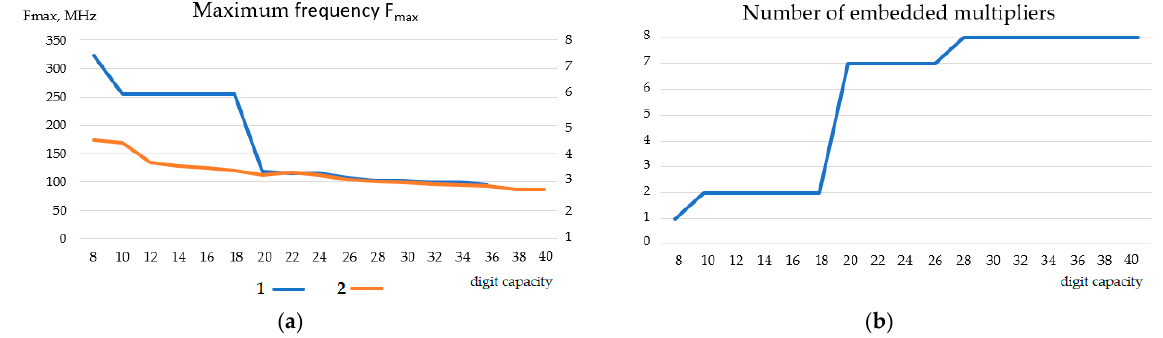
Figure 14. Comparison of constant multipliers built with the proposed algorithm and assembled on the basis of built-in FPGA multipliers: ( a ) comparison of the maximum frequency: 1—multipliers assembled on the basis of embedded FPGA multipliers, 2—multipliers by a constant built with the proposed algorithm; ( b ) number of the embedded FPGA multipliers.